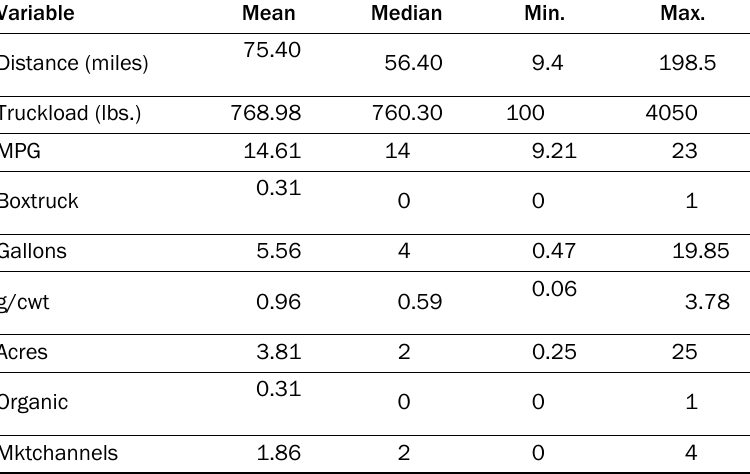
Table 2. Descriptive Statistics for Local Farmer Survey